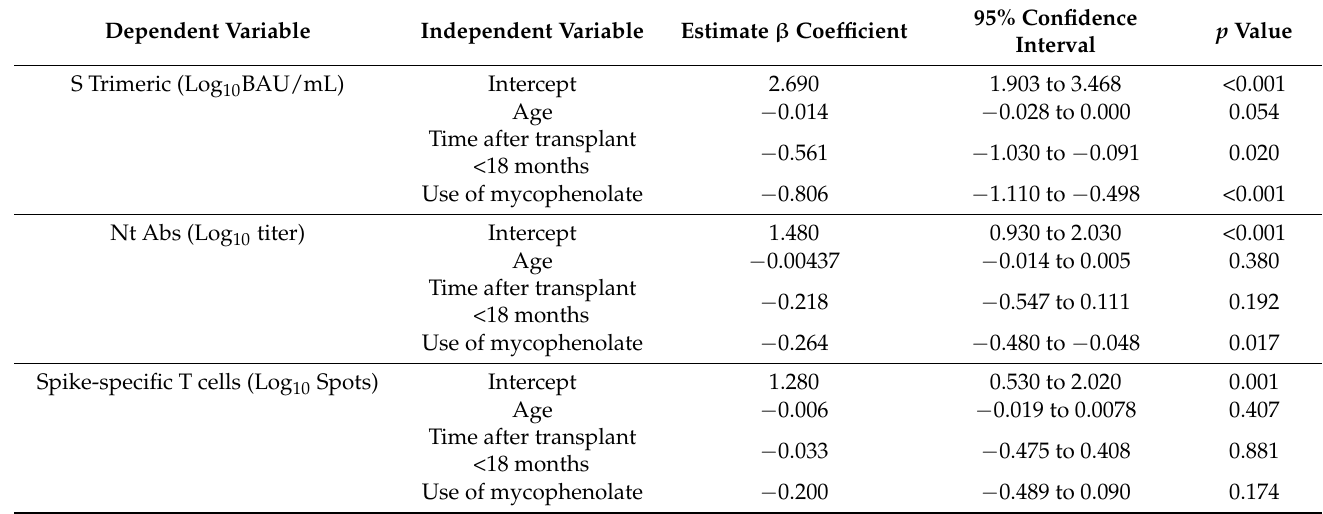
Table 2. Multiple linear regression analysis of factors potentially associated with vaccine response in transplant recipients. Dependent Variable Independent Variable Estimate β